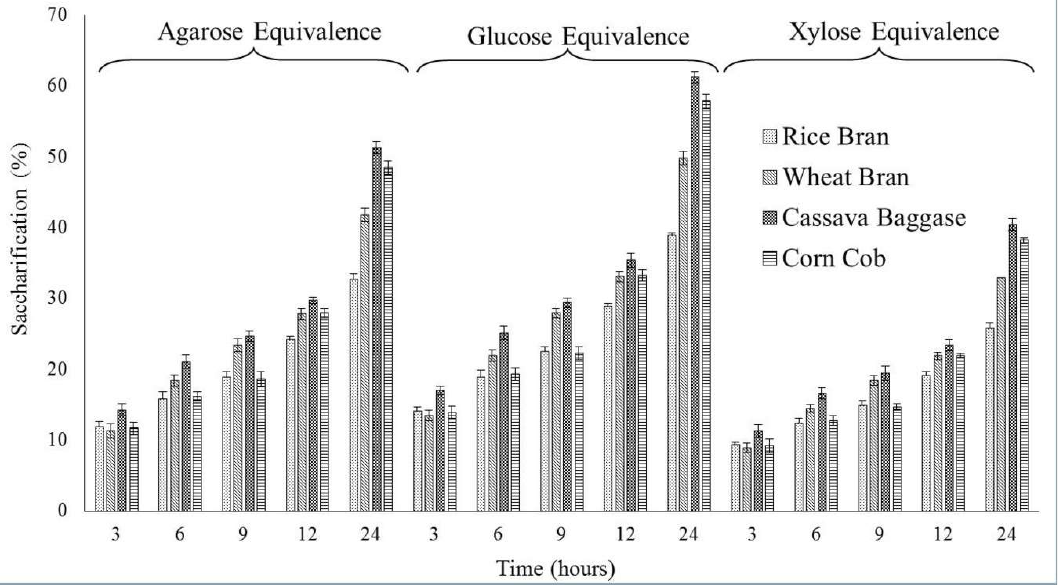
Figure 9. Saccharification rates of the coproduced enzyme mixture on different lignocellulose sub- strates in terms of agarose, glucose and xylose equivalents.